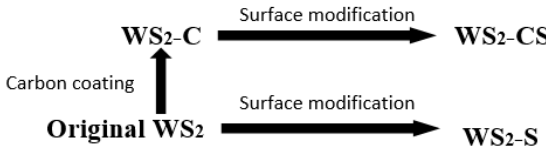
Figure 1. Schematic diagram of the preparation of nanoparticles.